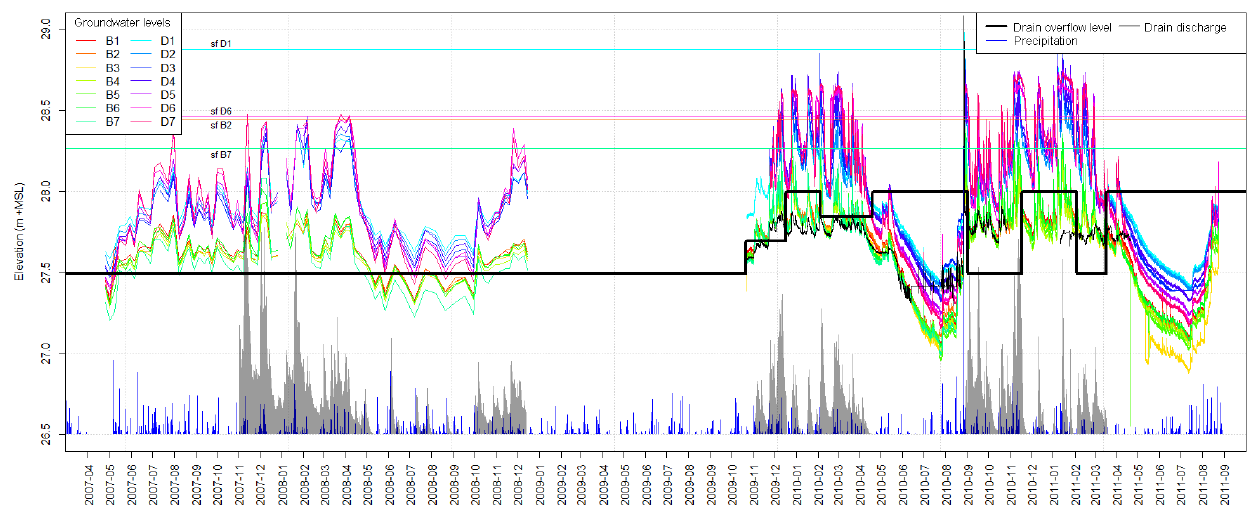
Figure 5. Combined results of hydrological measurements. The time series shown are (1) the overflow level of the drains (fixed at 27.5 in reference period, variable in controlled drainage period) in black, (2) the groundwater levels of the two transects B and D, and (3) in the lower part the drainage flux (grey) and precipitation (blue). The surface elevations at the lowest and highest groundwater monitoring locations of transects B and D are shown in colored horizontal